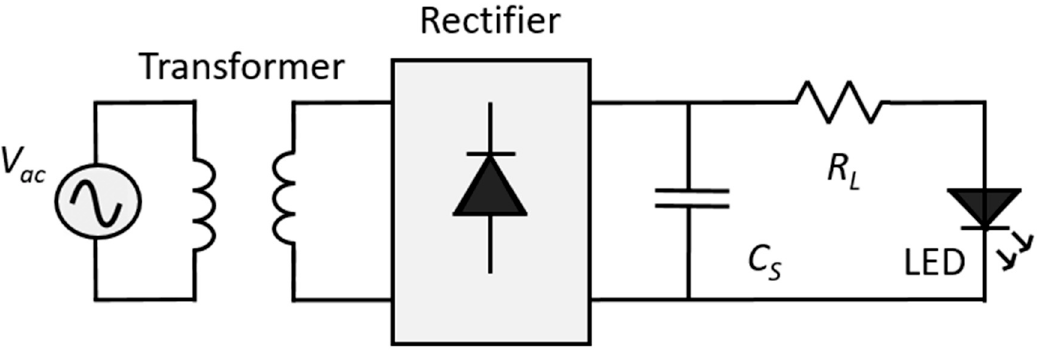
Figure 1. Typical application of a passive “lossy” LED driver.